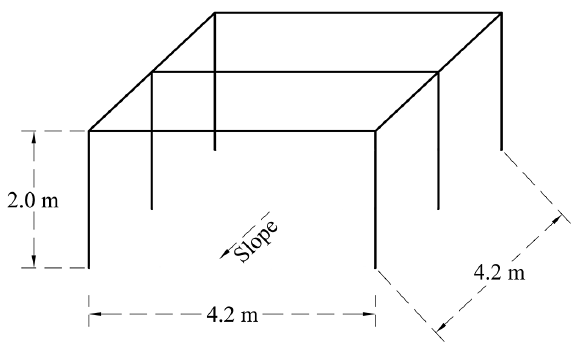
Figure 3. Schematic of the rainfall simulator